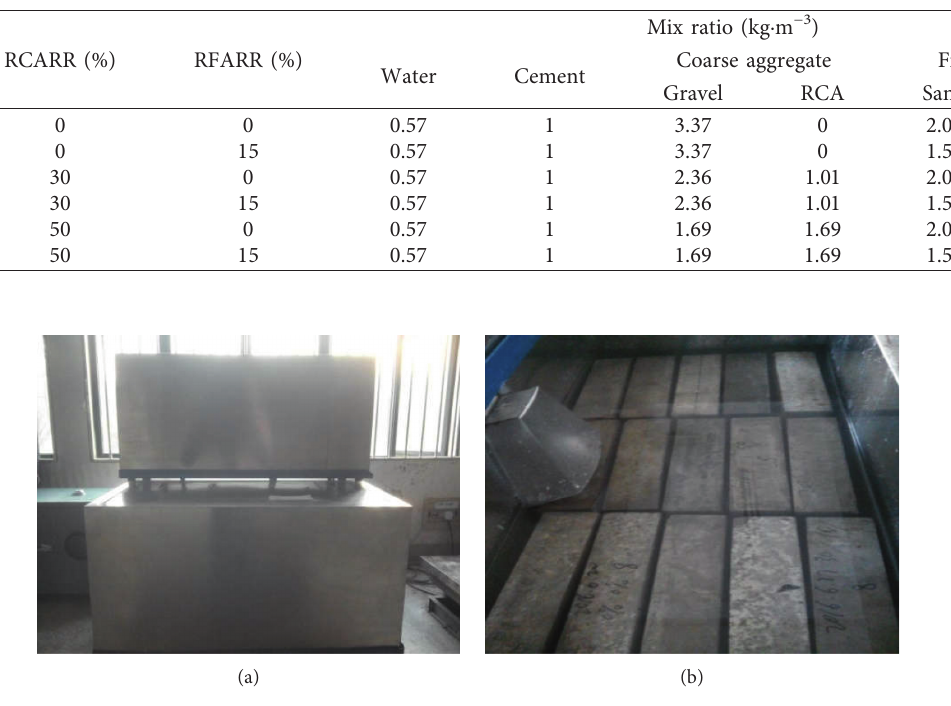
Figure 2: Sieve weight. Table 2: Recycled aggregate concrete mix ratio.